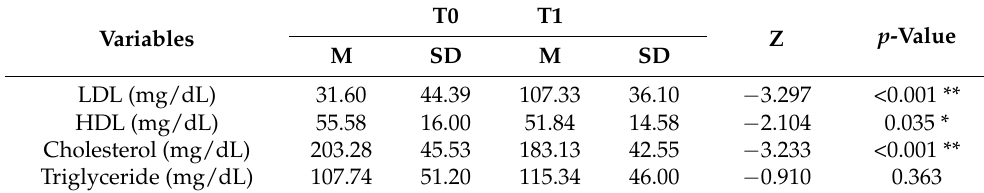
Table 2. Differences in Lipid markers between T0 and T1.